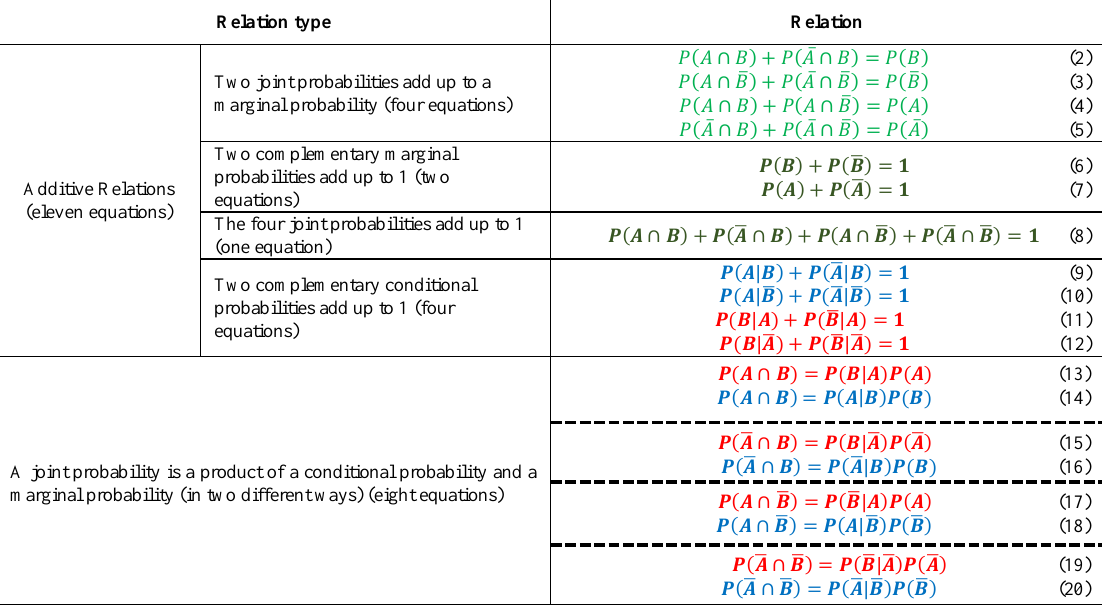
Additive Relations (eleven equations)